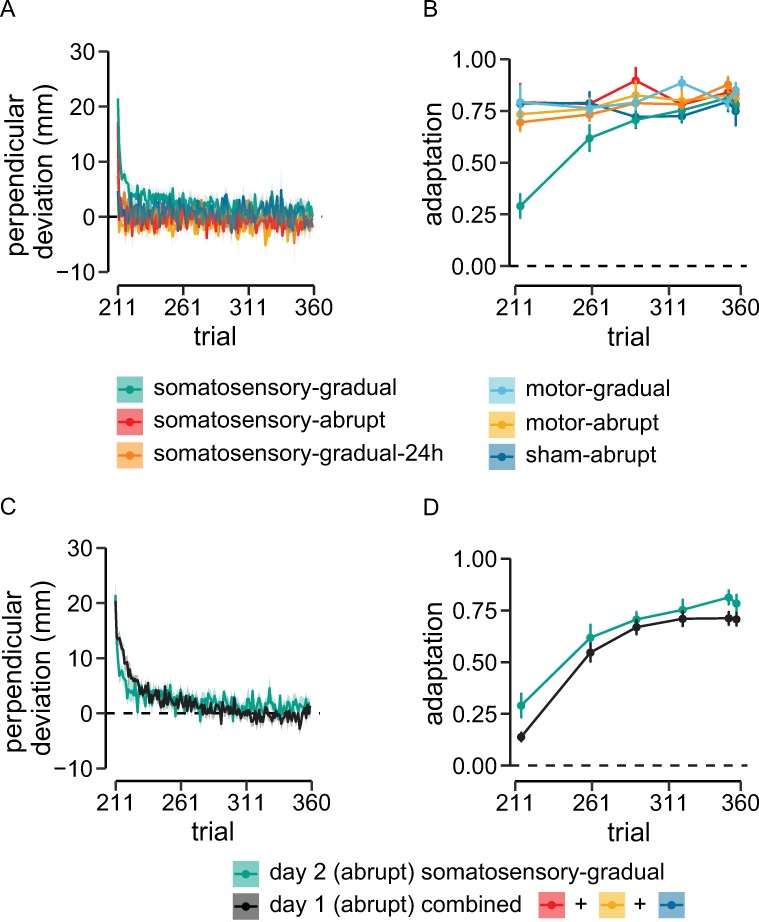
Suppression of somatosensory cortex causes participants to behave like naïve learners when reexposed to the perturbation.(A) There is rapid relearning in groups that had shown retention in the preceding error-clamp trials (motor-gradual, motor-abrupt, somatosensory-abrupt, somatosensory-gradual-24, sham-abrupt). Participants in somatosensory-gradual group showed slower relearning. (B) For participants shown in (A), from the beginning of the relearning session, adaptation coefficients are similar to those at the end of initial learning on day 1. (C) Relearning following cTBS for somatosensory-gradual group overlaid on averaged initial learning performance of naïve participants learning an abruptly introduced load. Note that all conditions shown here involved learning an abruptly introduced perturbation. (D) Overlay of adaptation coefficients during the relearning session for the somatosensory-gradual group with those of naïve participants. Performance of somatosensory-gradual group in the relearning session was similar to naïve learners, indicating the participation of somatosensory cortex in motor memory consolidation. Shaded regions and error bars give standard errors across participants. Data used to generate the figures in (A), (B), (C), and (D) can be found in S4 Data. cTBS, continuous theta-burst transcranial magnetic stimulation.